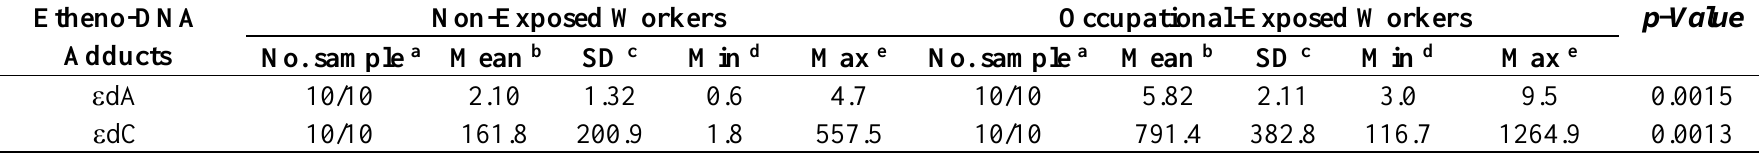
Table 3. Levels of etheno-DNA adducts (  dA and  dC) in human urine of occupational benzene-exposed and non-exposed workers (fmol/  mol creatine)